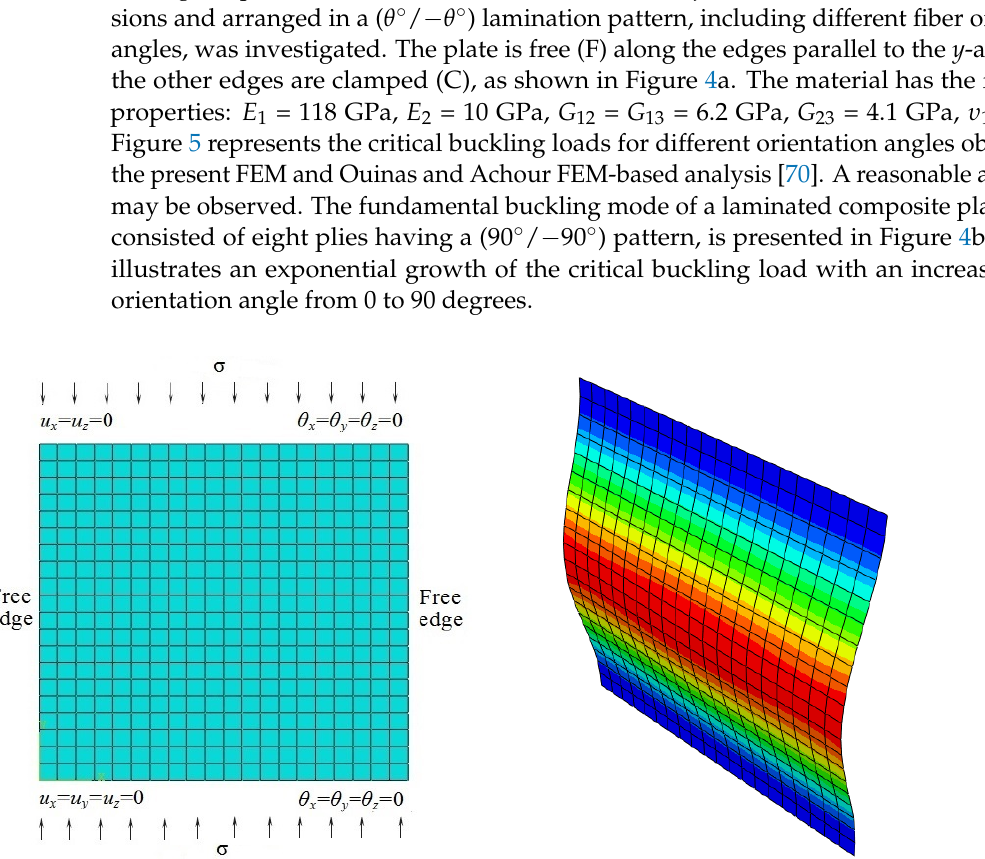
Table 6. Comparison of nondimensional buckling loads, N = N cr α 2 / E 2 h 3 , for 10-layer cross-ply [0 ◦ /90 ◦ ] 5 laminated rectangular plates with various mixed boundaries subjected to uniaxial compressions ( E 1 / E 2 = 40, α /h = 10, G 12 = G 13 = 0.6 E 2 ,